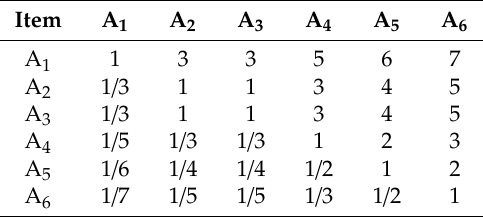
Table 6. Judgment matrix.